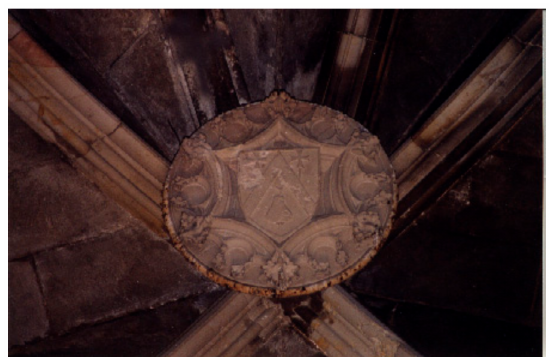
Figure 7. The coat of arms of Bishop Francisco Clemente Sapera (1410–1415) in the key of the vault of the Barcelona’s Cathedral.